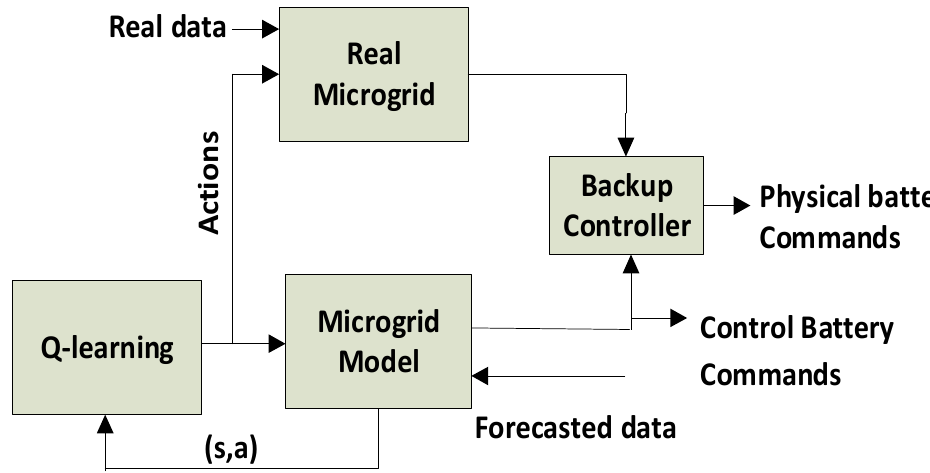
Figure 2. Offline implementation of the RL algorithm.